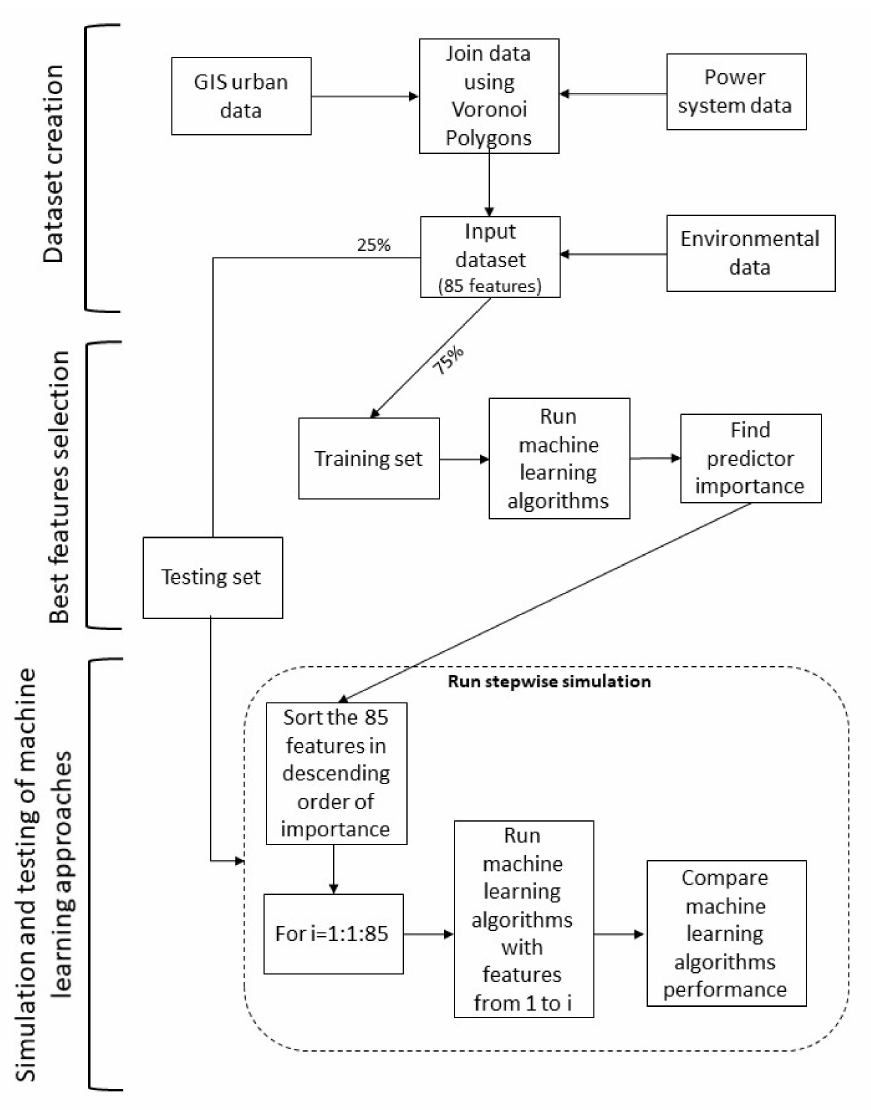
Figure 1. Flowchart of the proposed